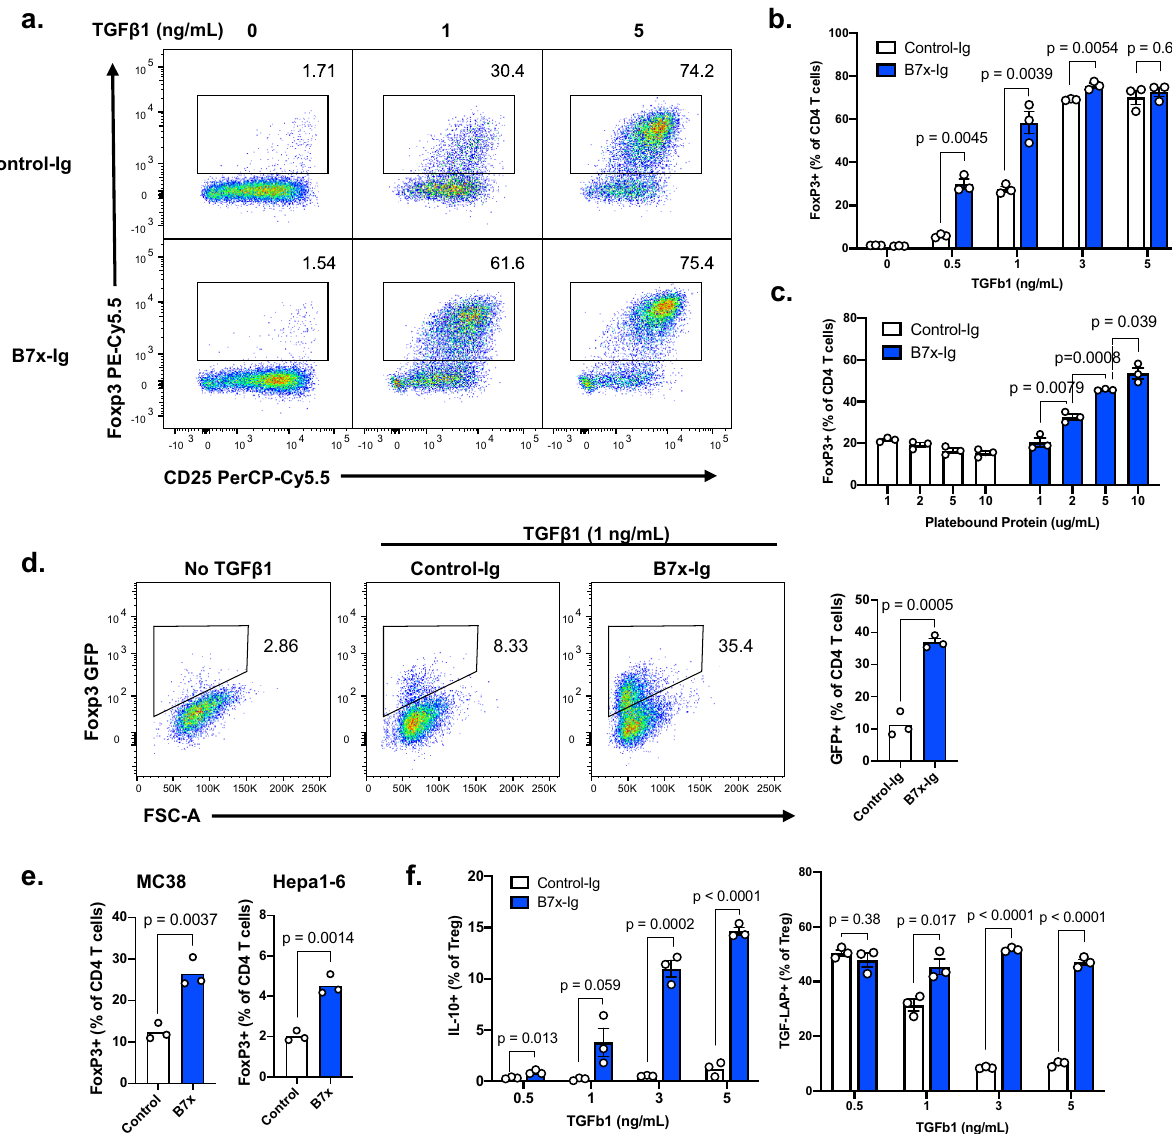
Fig. 2 B7x promotes the expression of Foxp3 in CD4 + T cells. a , b Splenic CD4 + T cells were isolated from wildtype mice and were cultured with iTreg- inducing conditions: anti-CD3, anti-CD28, IL-2, 10 μ g/mL recombinant B7x-Ig fusion protein or Control-Ig, and varying concentrations of TGF β 1, and expression of Foxp3 was measured by fl ow cytometry after 4 days. c CD4 + T cells were cultured as described in ( a ), except with fi xed 1ng/mL TGF β 1 and varying concentrations of B7x-Ig or Control-Ig, and expression of Foxp3 was assayed after 4 days. d CD4 + T cells from Foxp3-GFP/DTR mice were cultured in iTreg- inducing conditions with either B7x-Ig or Control-Ig and 2ng/mL TGF β 1, and expression of GFP was measured after 4 days. e CD4 + T cells were cultured with anti-CD3, anti-CD28, and either B7x-transduced or control MC38 or Hepa1-6 cells, and expression of Foxp3 in the T cells was analyzed after 4 days. f iTregs were induced with B7x-Ig or Control-Ig as described in ( a ), and expression of intracellular IL-10 and surface TGF-LAP was measured after 4 days. Error bars represent SEM, P values were calculated by two-tailed Student ’ s T -test. Results are representative of three independent